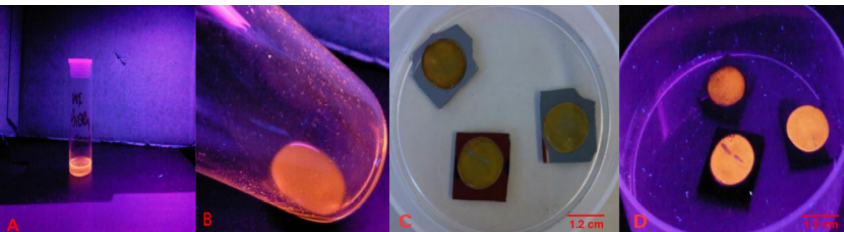
Figure 2. ( A ) n C 11 alkyl-capped SiQDs as a toluene sol and ( B ) after evaporation of the toluene; both photographs taken under illumination with an Hg lamp ( λ = 365 nm) to show the orange fluorescence. ( C ) The porous silicon, an approximately circular, brown–yellow area formed on the top of the silicon chip. ( D ) A fluorescent image of porous silicon under UV-lamp (Hg, λ = 365 nm).